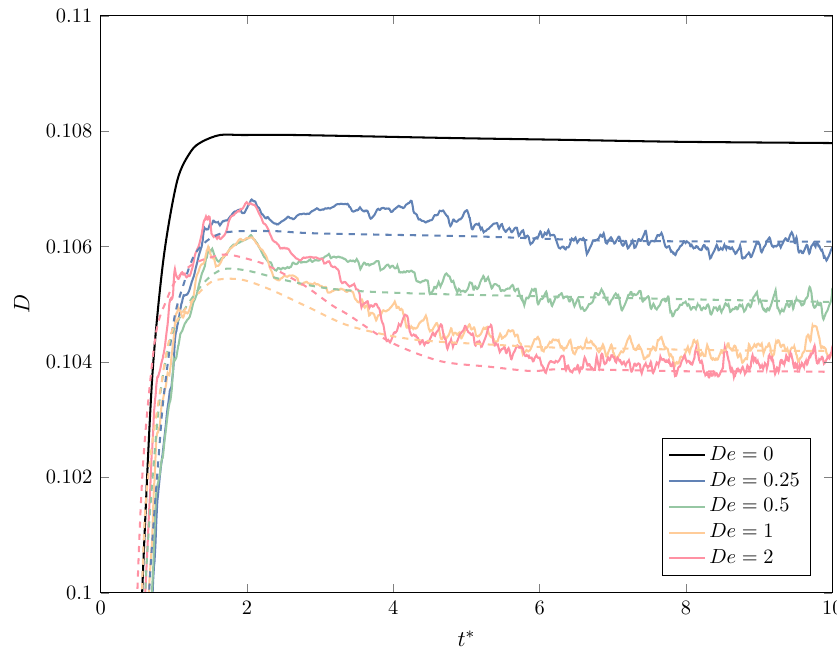
Figure 5. Comparison of the evolution of deformation for a non-Newtonian (Oldroyd-B) drop in a Newtonian matrix of equal viscosity after the abrupt start of shear flow, for increasing values of the Deborah number De , between our results (solid line) and those found in Yue et al. [21] (dashed line).